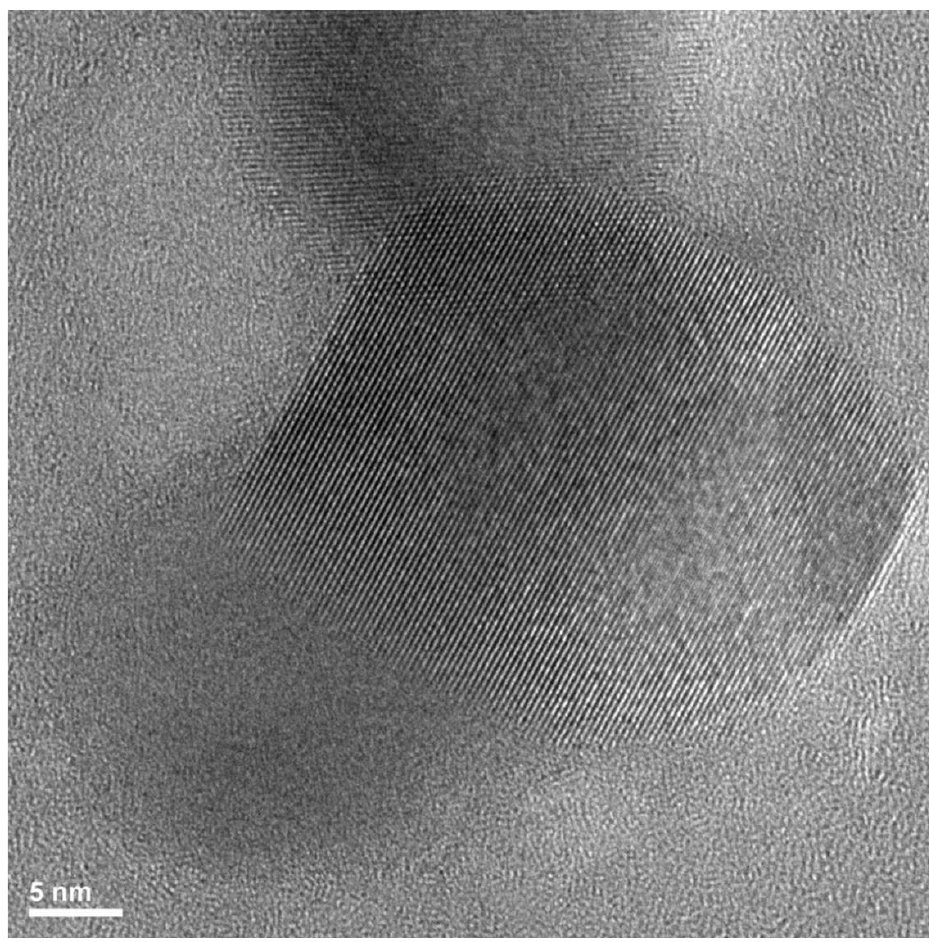
Figure 2. HRTEM micrograph of EPO_6%Si_2.32.